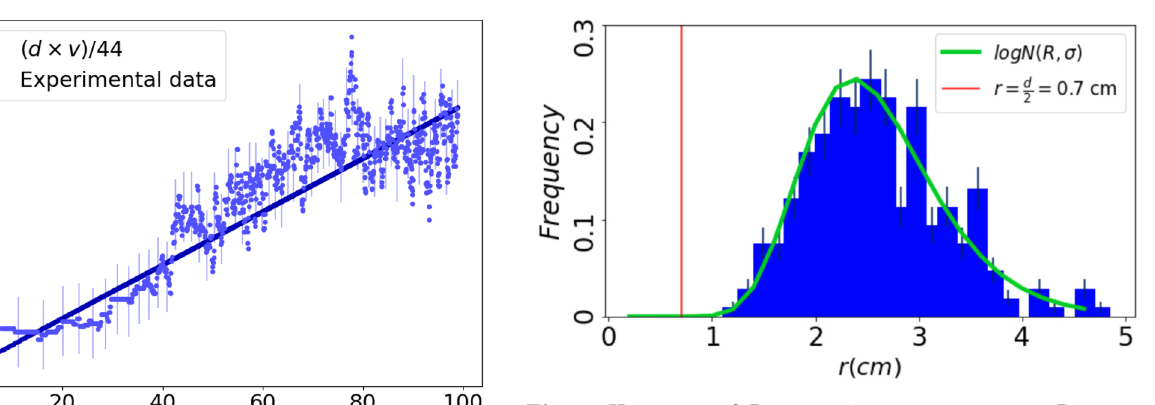
Fig. 5. Histogram of R a , σ = 6 . 75 ± 0 . 04 mm, µ = R = 26 ± 3 mm, d = 1 . 4 ± 0 . 04 cm. As described in Figure 3 R a must be larger than d which is represented here in Figure 5 with the 2 vertical red